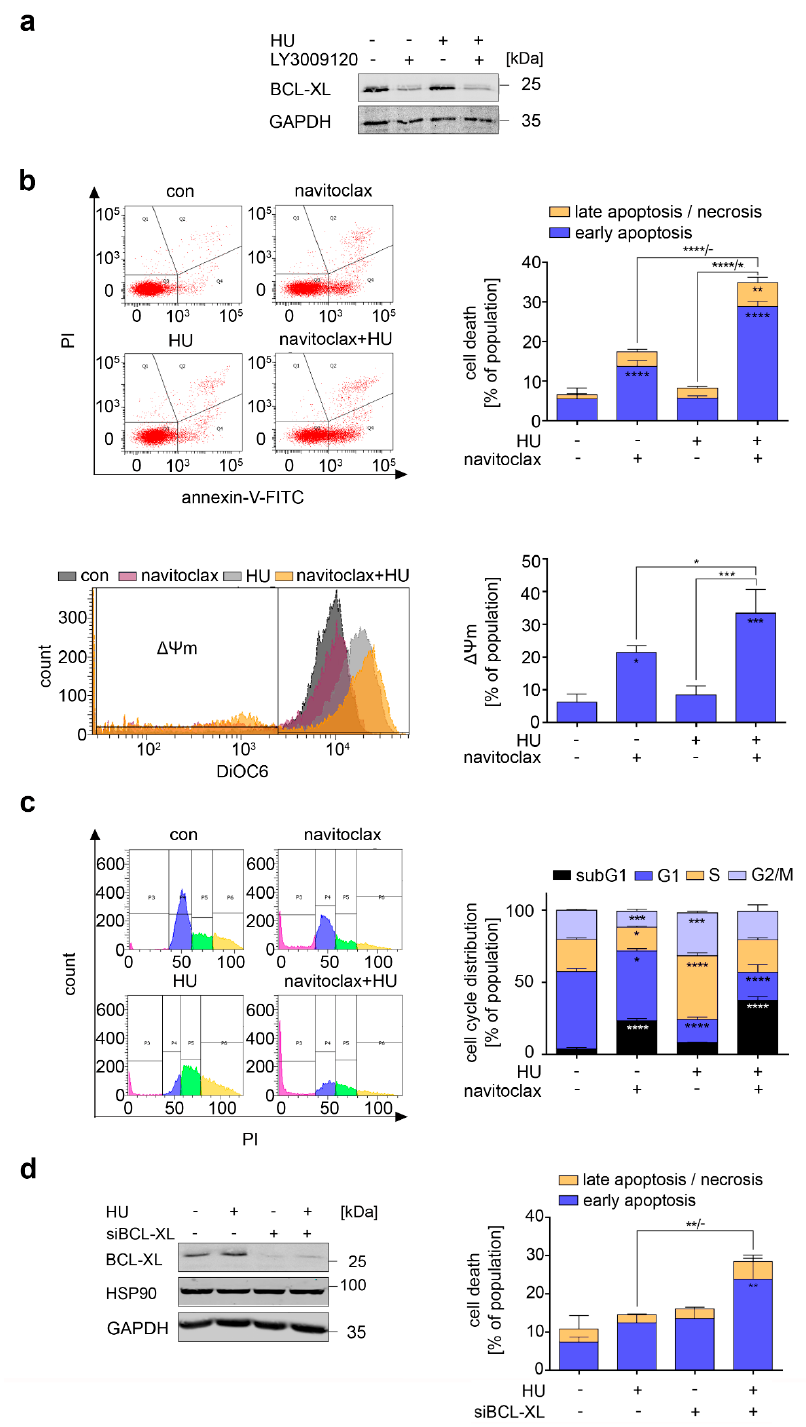
Figure 3. Pro-apoptotic effects of inhibition of BCL-XL are more pronounced in cells with replication stress. ( a ) Immunoblot of K562 cells treated with 1 µM LY3009120 and 1 mM hydroxyurea (HU) for 24 h shows BCL-XL; GAPDH, loading control. ( b ) Upper left: Exemplary dot plots of K562 cells treated with 1 µM navitoclax and 1 mM HU for 24 h. Cells were stained with annexin-V-FITC and PI and analyzed by flow cytometry. Upper right: Cell death calculations of annexin and PI stained K562 cells treated as mentioned before; n = 3 ± SD; two-way ANOVA; Bonferroni’s multiple comparisons test: * p < 0.05; ** p < 0.01; **** p < 0.0001. Lower left: Representative overlay histogram of